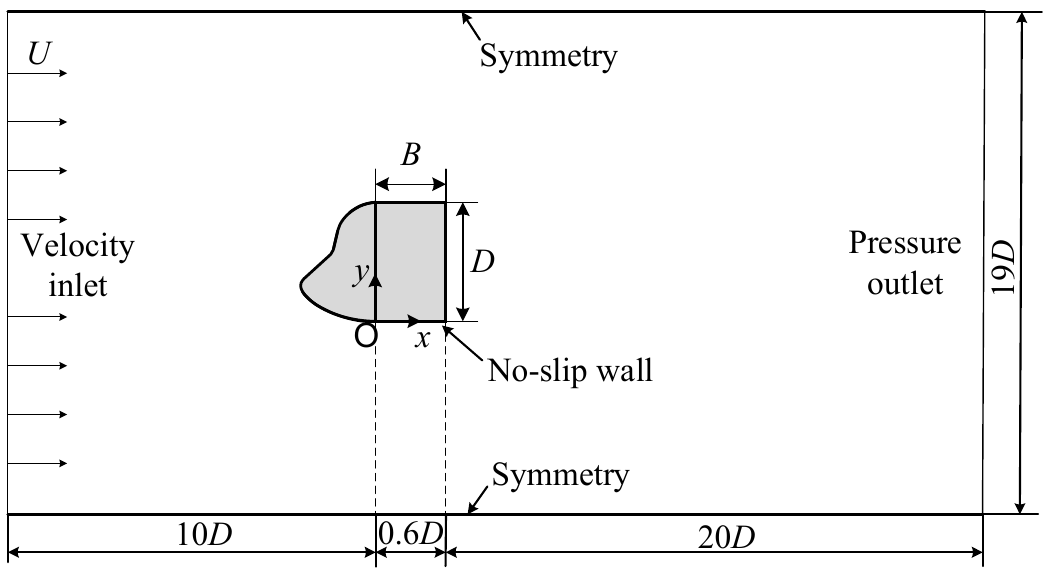
Figure 5. The geometry of the flow domain and boundary conditions.